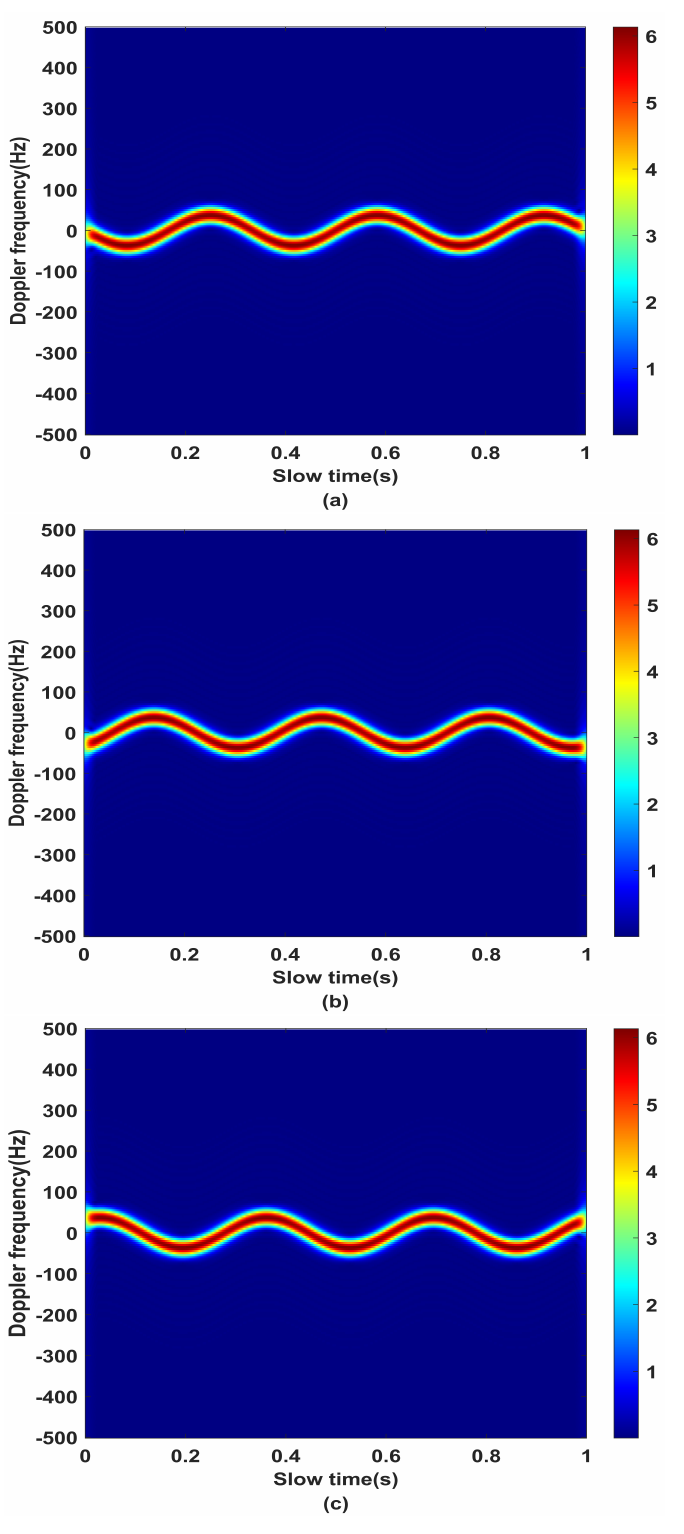
Figure 10. TF diagram of the angular Doppler: ( a ) angular Doppler of scatterer 1, ( b ) angular Doppler of scatterer 2, ( c ) angular Doppler of scatterer